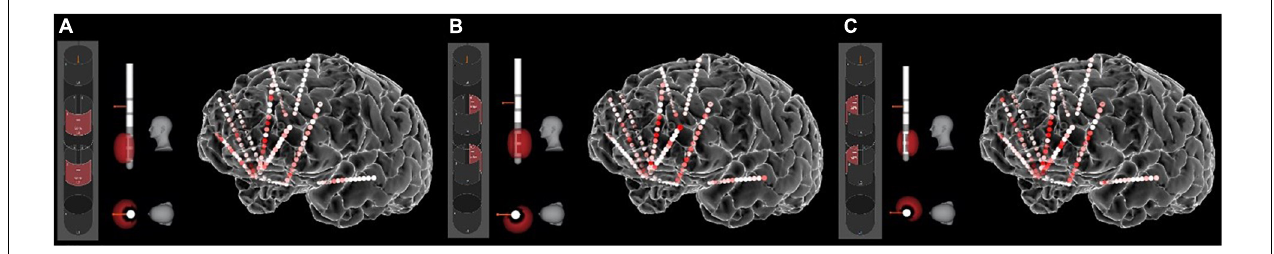
FIGURE 4 | Stimulation-induced network states. The sEEG recordings allow us to measure the “neural state” produced by any particular set of stimulation parameters. Here the heat map shows gamma (40–70 Hz) power in response to stimulation of various contact combinations on the left SCC DBS lead. (A) Contact configuration 2–5 (anterior stack of segmented contacts). (B) Contact configuration 3–6 (posterior-left stack). (C) Contact configuration 4–7 (posterior-right stack). Other parameters were frequency of 130 Hz, pulse width of 180 ms, and amplitude of 5 mA. Other combinations of these parameters produce different neural states, all of which can be quantified with the sEEG recordings.